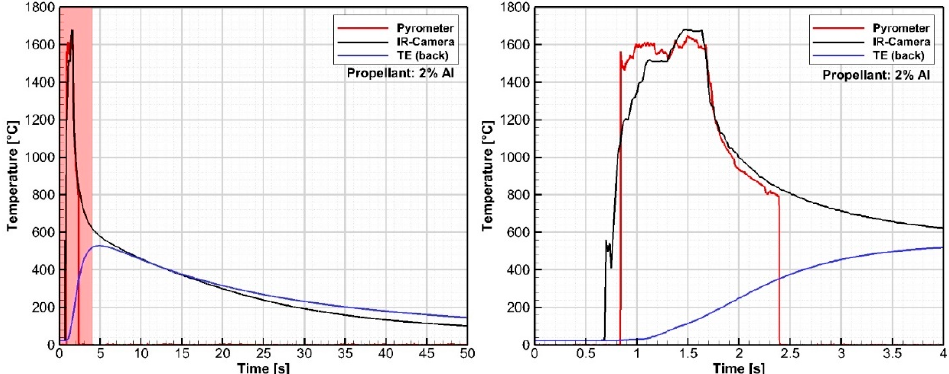
Figure 8. Infrared images with marked positions taken for the temperature comparison purposes, ( left ) at 2% Al propellant, ( right ) at 8% Al propellant.